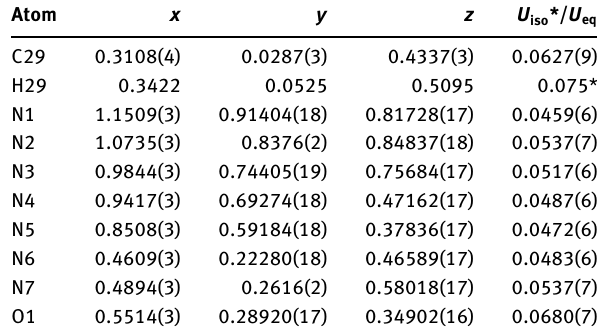
Table 2: Fractional atomic coordinates and isotropic or equivalent isotropic displacement parameters (Å 2